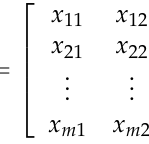
2. The original algorithm normalizes the data here, inside the WASPAS-SVNS algorithm, but for the iterative process it does not work because the local min–max and global min–max values are not the same, so we need to define boundaries before this step [33]. Normalization is made in the criteria functions to fit in the range of 0 to 1 (7). v represents current criteria value and v max is the highest possible value for that criterion for the selected matrix size. (cid:101) x ij is a normalized index ij criteria value of matrix X ;